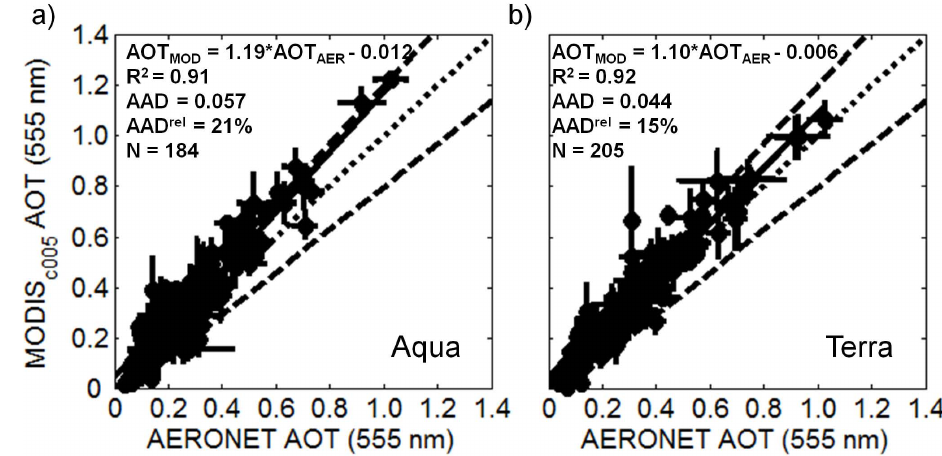
Fig. 6. Comparison between MODIS c005 AOT and AERONET AOT at 555nm for (a) Aqua and (b) Terra and the time periods investigated. The solid, dashed and dotted lines represent linear fits, expected uncertainties for one standard deviation of the MODIS c005 aerosol retrievals and 1-to-1 line, respectively. The explanation of abbreviations is given in Sect. 2.3.